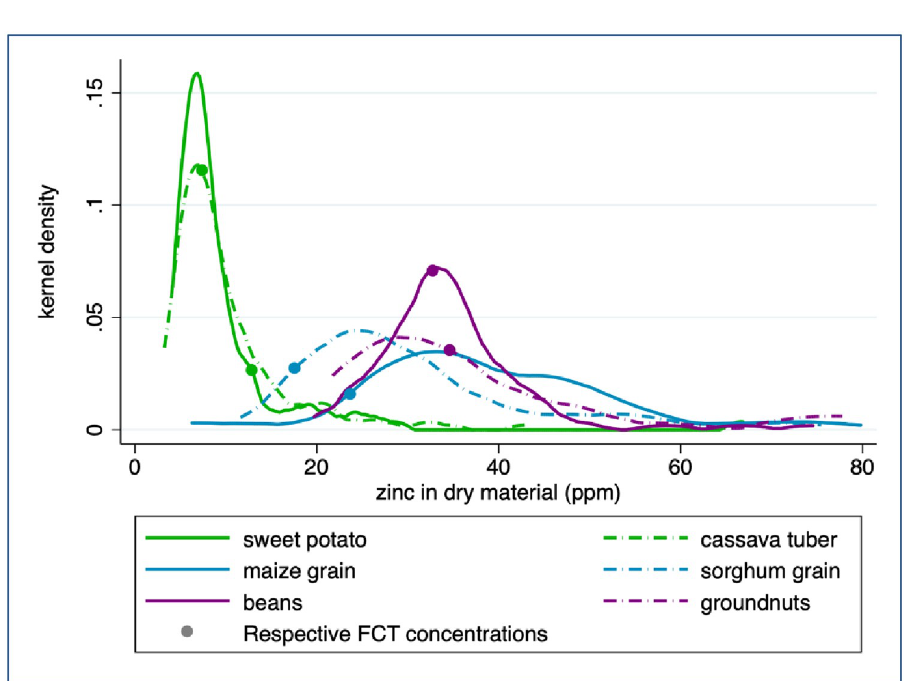
Fig 3. Zinc concentration in household farm samples. Values exceeding 80 ppm are not displayed. FCT sources are listed under Table 1. https://doi.org/10.1371/journal.pone.0234770.g003 The Zn concentrations of market-sampled crops were less heterogeneous than those col- lected from household farms, but again the FCT does not represent the median Zn concentra- tions of 4 of the 6 crops. The mean Zn concentration measured in our samples (6.6 ppm) is statistically indistinguishable from the mean concentration of 5.6 ppm reported by Tidemann- Andersen et al. [50] for maize flour samples purchased from Ugandan markets (p = 0.411), once their figures are adjusted to provide ppm dry matter. (Tidemann-Andersen et al. [50] report sample values as 4.2, 3.6, and 7.0 ppm wet matter. According to the reported moisture content of maize flour, this is equivalent to 4.77, 4.09, and 7.95 ppm dry matter, resulting in a Table 1. Zn concentration measured in staple crops collected from household farms (ppm dry mass; 10 ppm = 1 mg 100 g -1 ). Household Sample Value FCT % < Min Median Mean Max Sdev Value FCT Maize grain 6.3 38.3 ��� 42.3 ��� 7.1 Sorghum grain 11.6 28.2 ��� Sweet potato Cassava Beans 19.7 Groundnuts 21.7 34.0 50.0 Stars denote significant differences compared to FCT values using a t-test for mean values and a Wilcoxon test for median values ( ��� p < 0.01, �� p < 0.05, � p < 0.1). Sources for FCT values: HarvestPlus 1001/1004 from USDA-21 20014 (maize grain), HarvestPlus 1105 from WFDA 1010 (sorghum grain, Senegal), HarvestPlus 3003 from USDA-21 11507 (sweet potato), HarvestPlus 2001 from USDA-21 11134 (cassava), HarvestPlus 6121 from USDA-21 16027 (beans), and HarvestPlus 8015 from USDA-21 16087